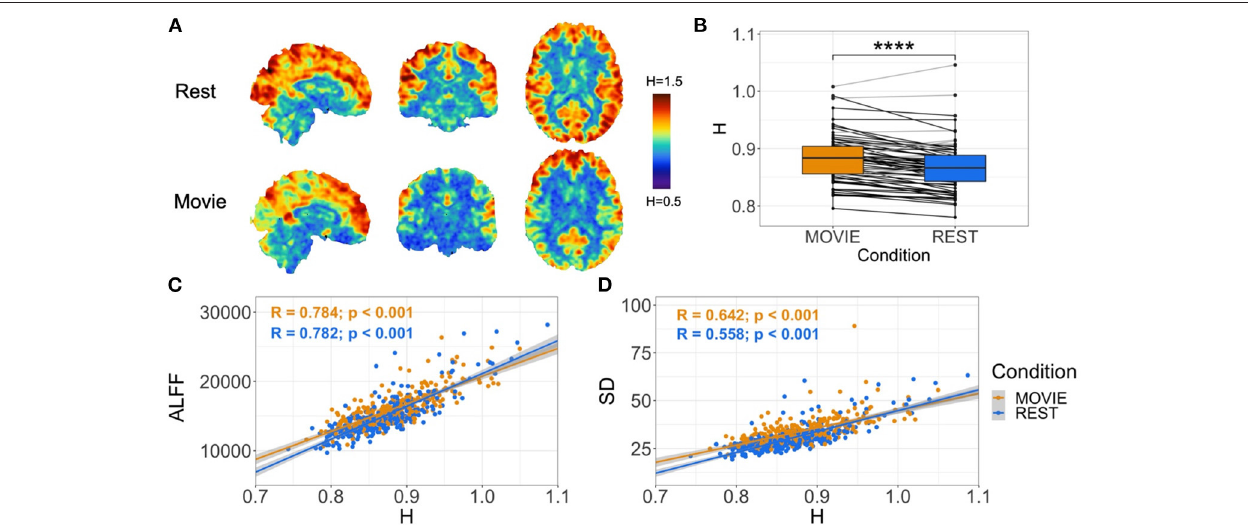
FIGURE 2 | Cross-condition comparison of whole-brain H ( N = 72). (A) H values in rest (top) and movie-watching (bottom) of sample sagittal, coronal and axial slices in a single subject. Images show distinction between cortical gray and white matter, and values that appear greater in Movie relative to Rest in a non-homogeneous distribution. (B) Box-plot of H between Movie Watching (left, orange) and Rest (right, blue) showing group-level finding that H-values are significantly greater in Movie. Black lines depict participants with greater H in Movie than Rest, and light-gray lines depict participants with lower H in Movie than Rest. (C,D) Scatter-plot of H vs. ALFF and H vs. standard deviation of BOLD values, respectively, with Movie (orange) and Rest (blue), showing positive correlations for both conditions in both cases. Gray shadows over orange and blue lines depict the 95% confidence interval for predictions from a linear model.